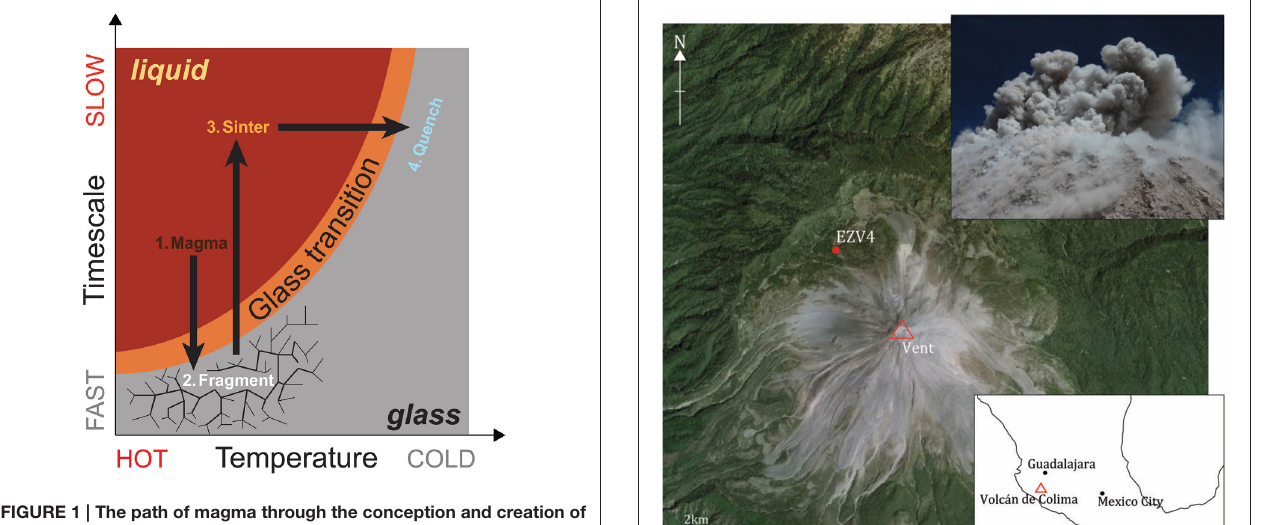
FIGURE 1 | The path of magma through the conception and creation of tuffisite veins in terms of the glass transition of silicate liquid in time-reciprocal temperature space (after Dingwell, 1996): (1) magma is (2) fragmented, forcing the melt through the glass transition to produce fine-grained particles; these then relax and (3) sinter back together before cooling to (4) quench in the tuffisite structure. 2008; Vasseur et al., 2013; Wadsworth et al., 2014), it is yet to encompass the complexity of natural crystal-bearing magmas.